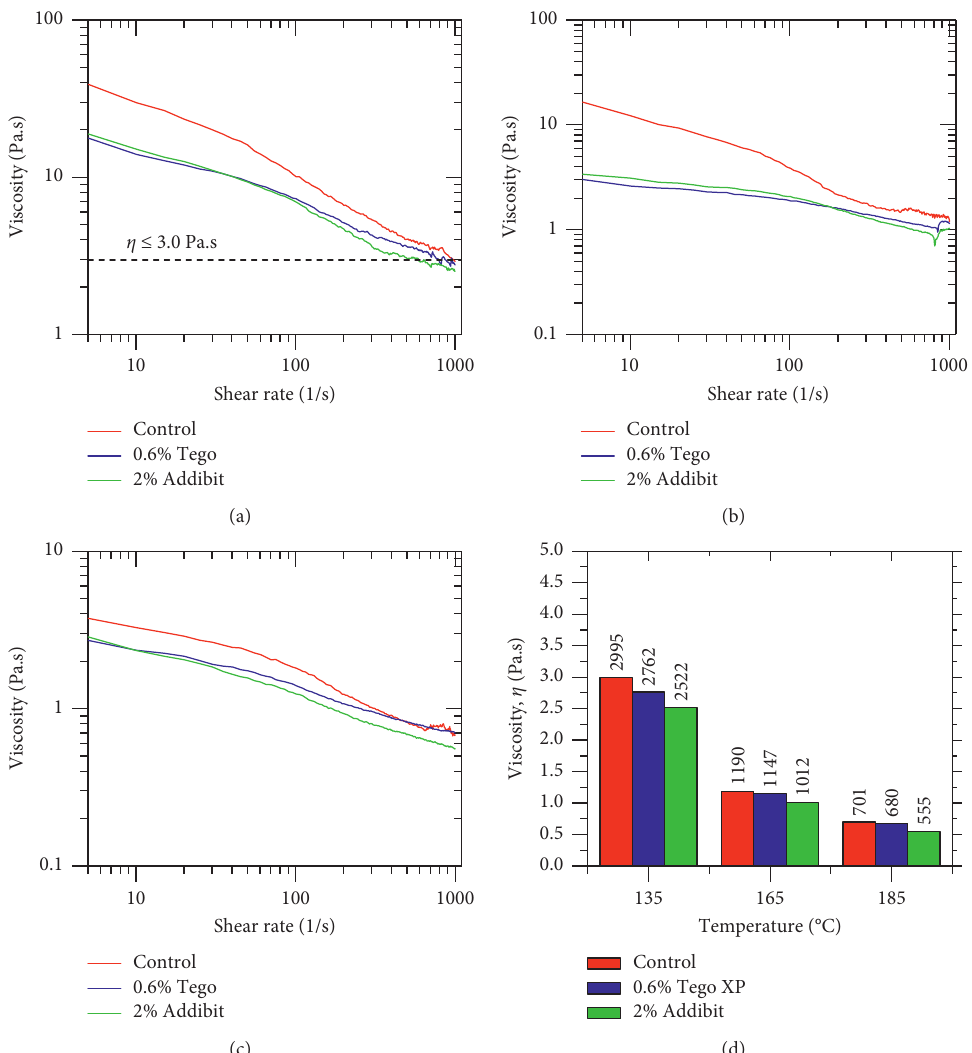
Figure 6: Viscosity and shear rate of CRM asphalt with and without WMA additives at (a) 135 ° C, (b) 165 ° C, and (c) 185 ° C and (d) viscosity- temperature at 1000 shearing rate